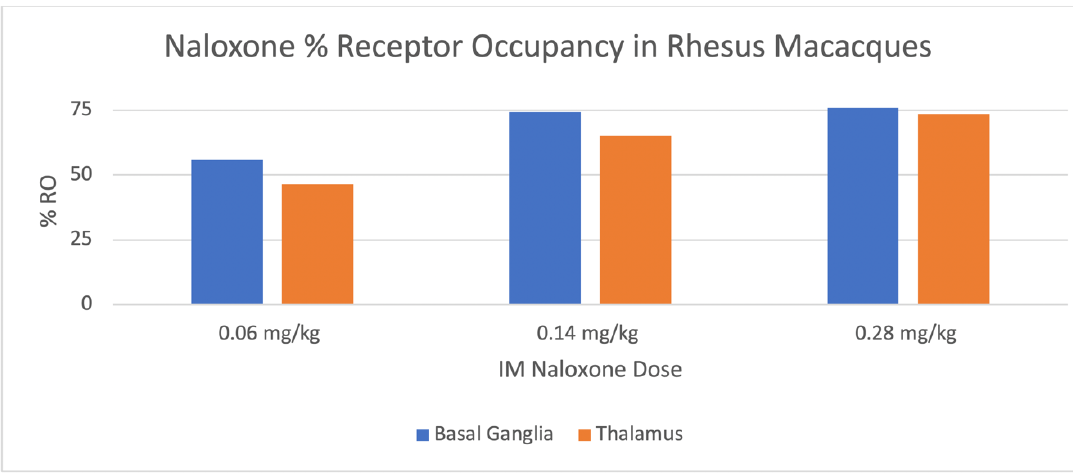
Figure 2. Mean % RO by intramuscular (IM)